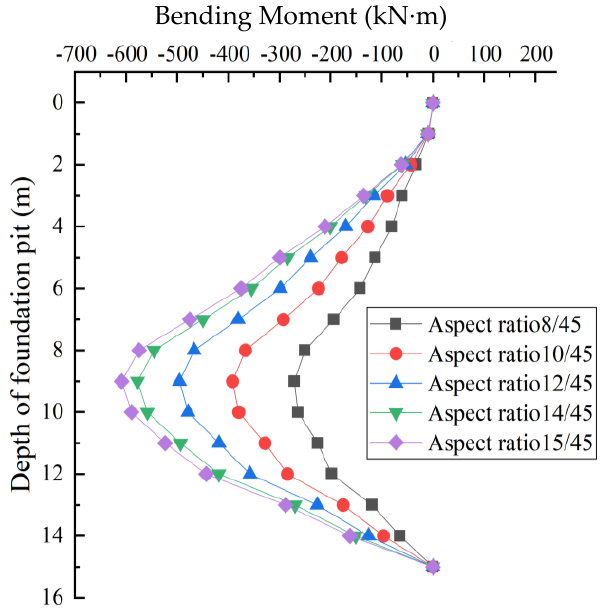
Figure 18. Pile bending moments.